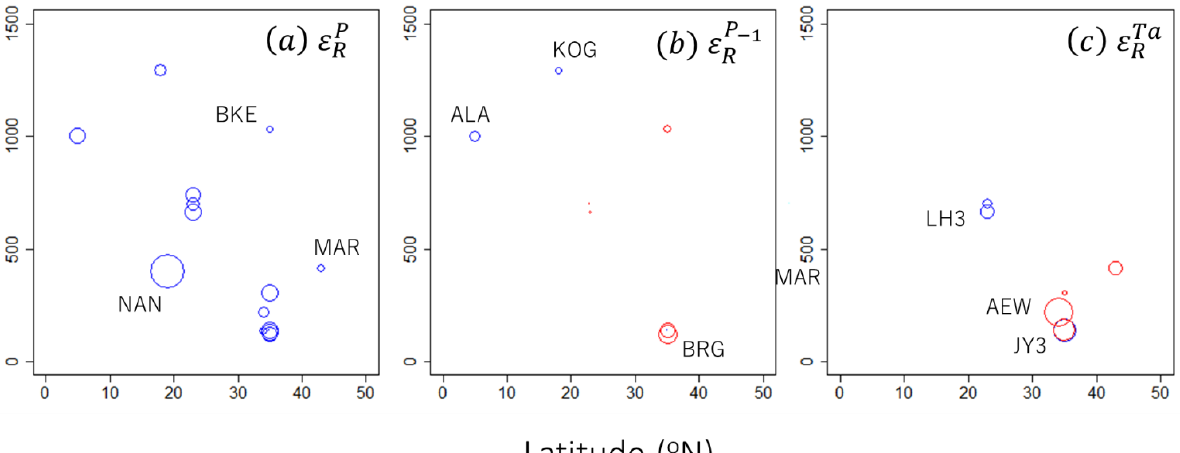
Figure 4. Coefficient values in the elasticity models along altitudinal- and a latitudinal-gradients. Blue-colored and red-colored circles indicate positive and negative coefficients, respectively, and their magnitudes are represented by diameter size.